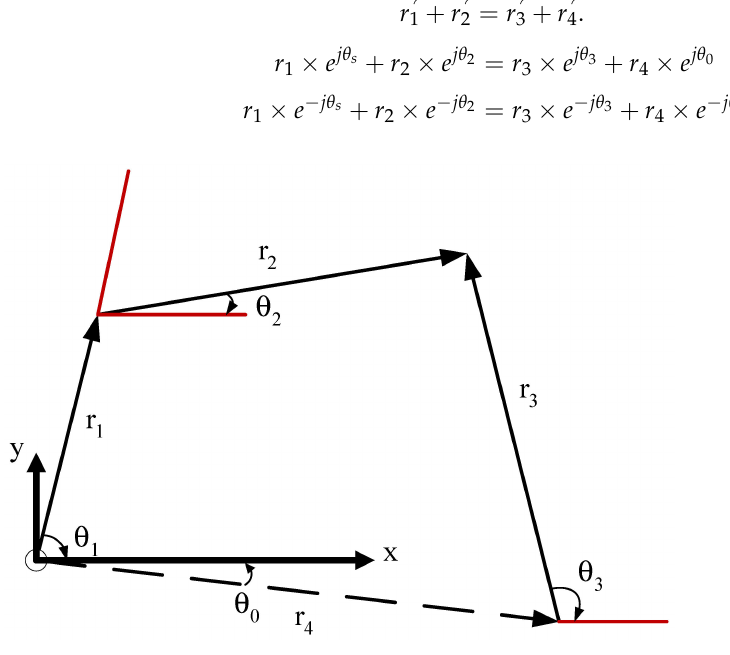
Figure 5. A vector representation of four-bar linkage mechanism. Where the red lines represent reference